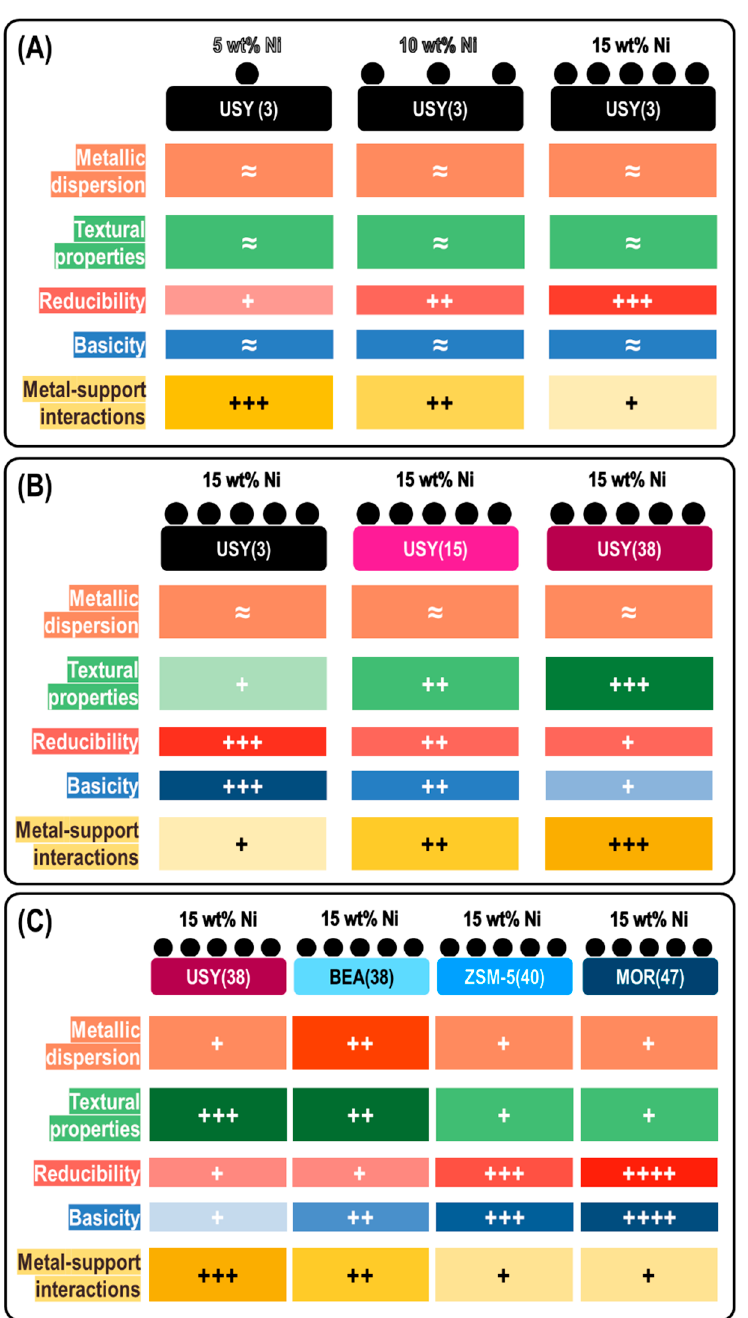
Figure 9. Comparison of catalysts’ properties for: ( A ) Ni loading; ( B ) Si/Al ratio; and ( C ) Framework type samples. type